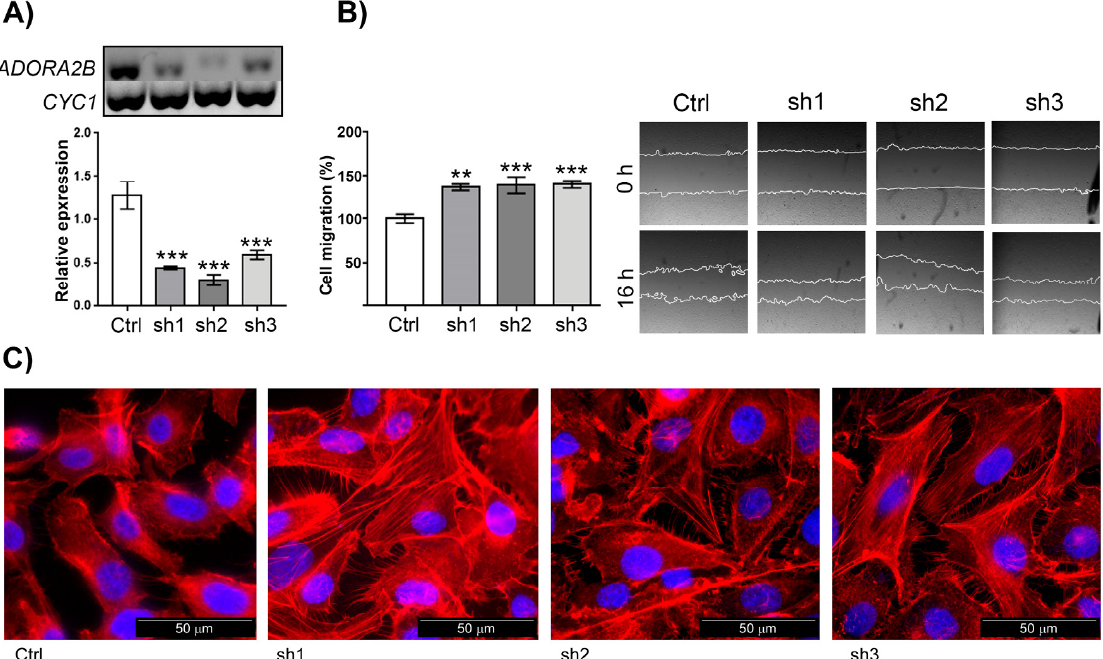
Figure 5. Knockdown of the ADORA2B transcript induced an increment in basal cell migration and in stress fiber formation. ( A ) Cultures of SKOV-3 cells were transduced with lentiviral particles carrying three different shRNAs directed against the ADORA2B transcript. The effect of knockdown was monitored by RT-PCR; CYC1 , coding for a subunit of cytochrome bc1 complex, was used as a constitutive transcript. Relative expression was analyzed by agarose gel electrophoresis densitometry. ( B ) Scratch assay was performed to estimate the cellular migration of control or ADORA2B -shRNA expressing SKOV-3 cells (sh1 to sh3), 16 h after the wound was made. In the graphs, bars represent the mean ± S.E.M. of three independent experiments. ** p < 0.05, *** p < 0.01. ( C ). The actin cytoskeleton of control or ADORA2B -shRNA expressing SKOV-3 cells was stained with rhodamine-coupled phalloidin and nuclei were counterstained with